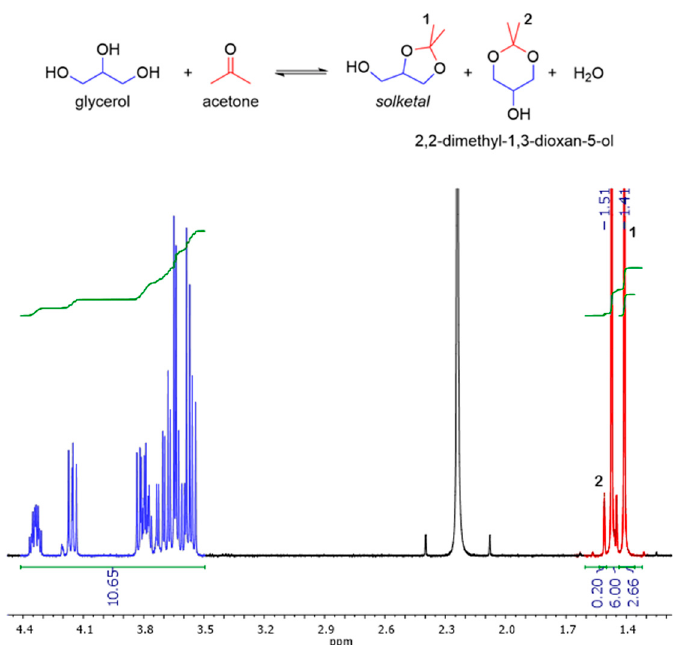
Figure 7. 1 H-NMR spectrum of a typical reaction mixture. In red, the integrals corresponding to the protons of the methyls of products, and in blue, the signals of the glyceryl portion of both the reactant and